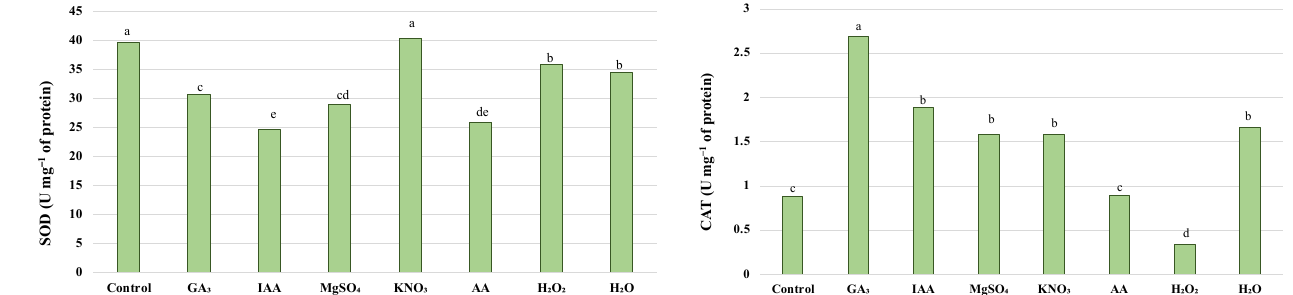
Figure 3. Activity of SOD and CAT in leaves of wheat seedlings after different priming treatments. Different letters above bars indicates that differences were not significant ( p > 0.05) using Tukey.